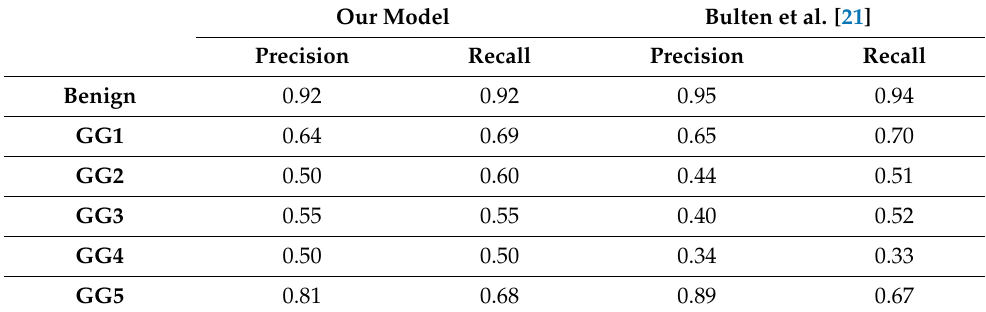
Table 5. The comparison between our DL approach and the current work for grade groups results.